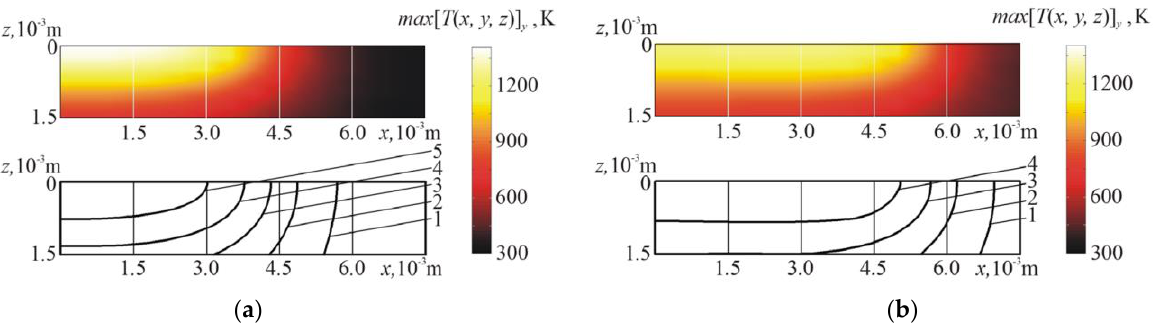
Figure 7. Maximum temperature values max [ T ( x, y, z )] y across the width of the heat-affected zone of a rectangle-shaped heat source, obtained by calculation considering the power 950 W, a constant linear velocity υ = 1.1 × 10 −2 m/s on the surface of chrome – nickel – molybdenum steel before ( a ) and after adjustment of power density ( b ). Temperature T : (isothermal: 1 – 600 K; 2 – 750 K; 3 – 900 K; 4 – 1050 K; 5 – 1200 K) [134].